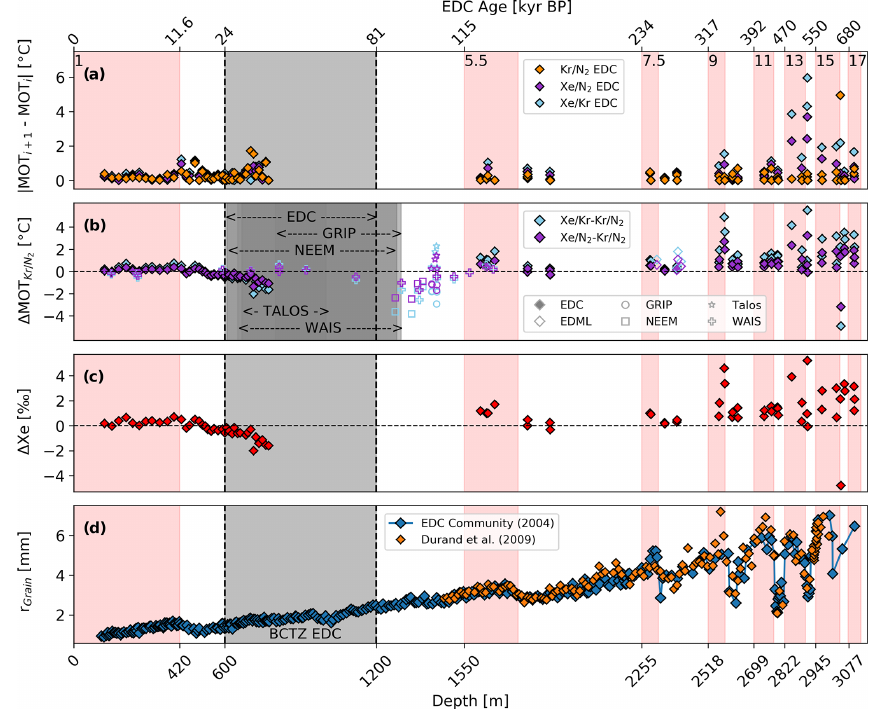
Figure 7. (a) Absolute MOT pair difference between two adjacent samples for the three different atmospheric noble gas ratios. (b) Difference in the MOT from δ Kr / Xe and δ Xe / N 2 compared to δ Kr / N 2 . EDC, GRIP, NEEM, and Talos samples were measured at the University of Bern. WAIS samples were measured by Bereiter et al. (2018b). The grey shaded bars and arrows indicate the BCTZ for the different cores as identified by Neff (2014). All data are corrected for gravitational and thermal fractionation using argon isotopes. EDC samples are also corrected for HID fractionation. (c) Potential xenon change required for the EDC samples to match the MOTs using a least square approach. Given in red is the potential xenon change that minimizes the difference between the MOTs derived from Xe / Kr, Kr / N 2 , and Xe / N 2 . Negative values indicate a xenon loss, i.e., a depletion of the raw elemental ratios Xe / N 2 and Xe / Kr caused by post-coring gas loss. Positive values represent apparent net xenon “gains” due to higher losses of krypton and nitrogen compared to xenon. (d) Evolution of the grain radius in the EDC core (EPICA community members, 2004; Durand et al., 2009). Note that the ages provided on the upper x axis only apply for samples from the EDC ice core. MIS interglacials (red shaded intervals) as identified by Masson-Delmotte et al. (2010) are labeled at the top for